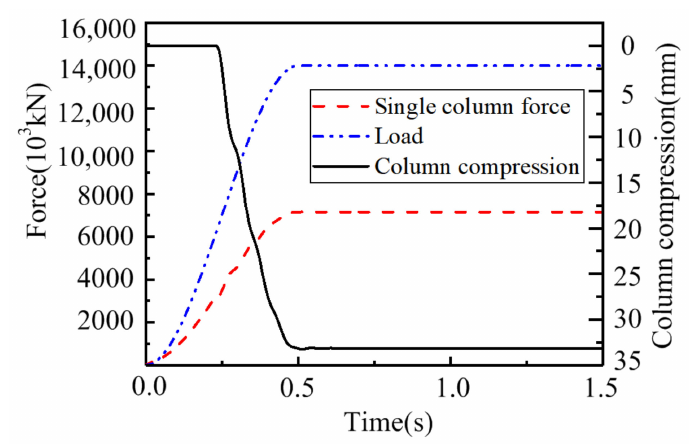
Figure 6. The stable working state diagram of the support under 14,000 kN